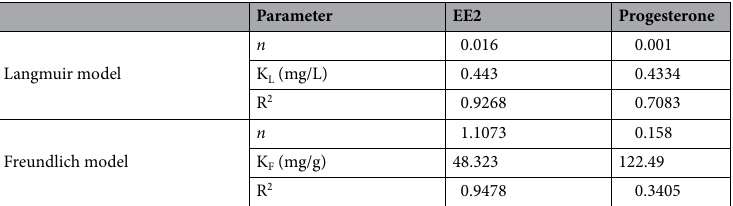
Parameter EE2 Progesterone Langmuir model